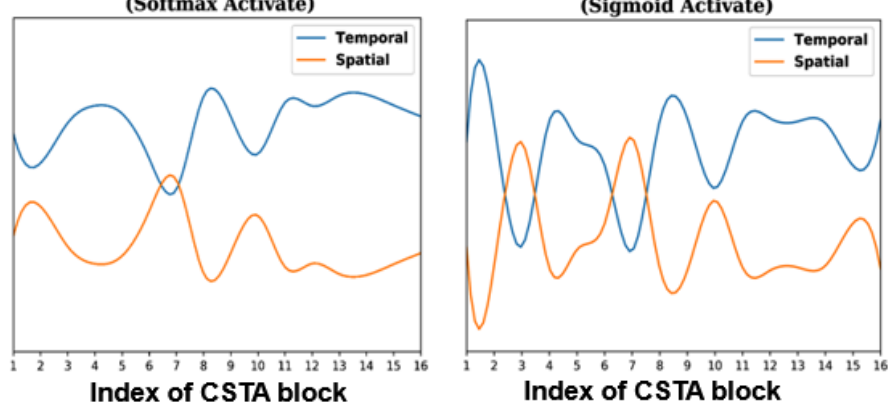
Figure 9. The activation function in STCA